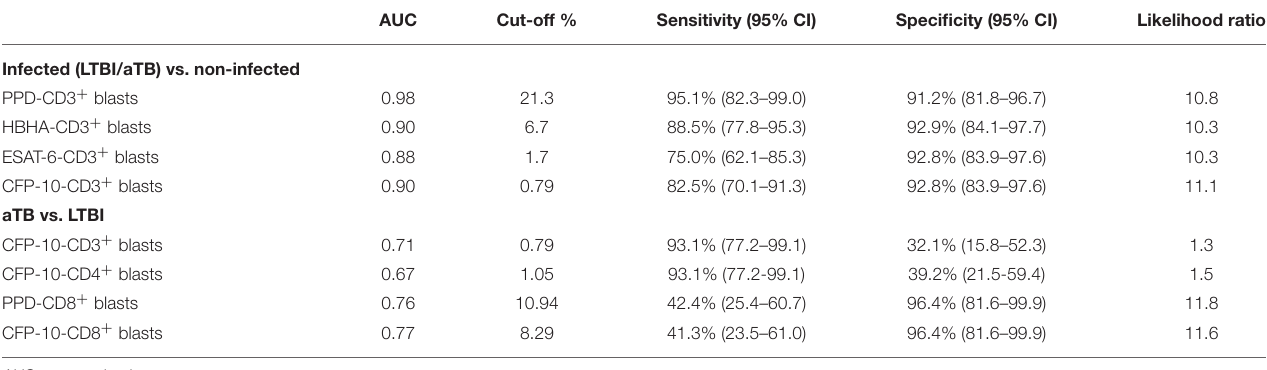
TABLE 3 | Diagnostic accuracy of the FASCIA.